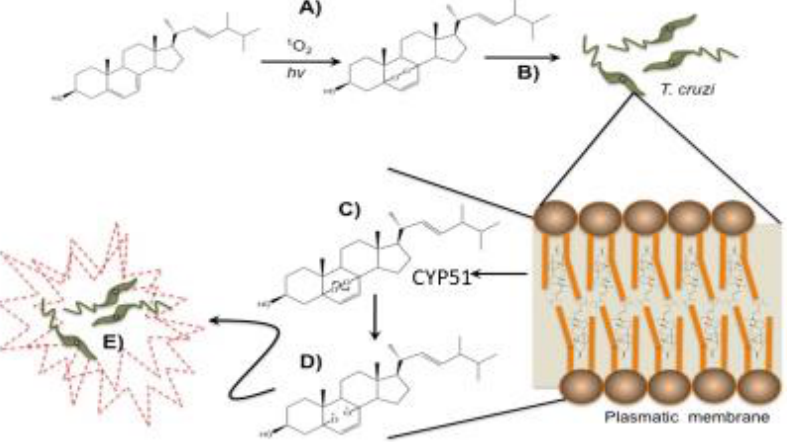
Figure 8. A hypothetical mechanism of action for the ergosterol peroxide oxidative burst. ( A ) ergosterol peroxide oxidation reaction; ( B ) ergosterol peroxide membrane docking; ( C , D ) breakage of the covalent oxygen bound after CYP51 association and triggering of the free radical reaction; ( E ) Tc cytotoxicity.